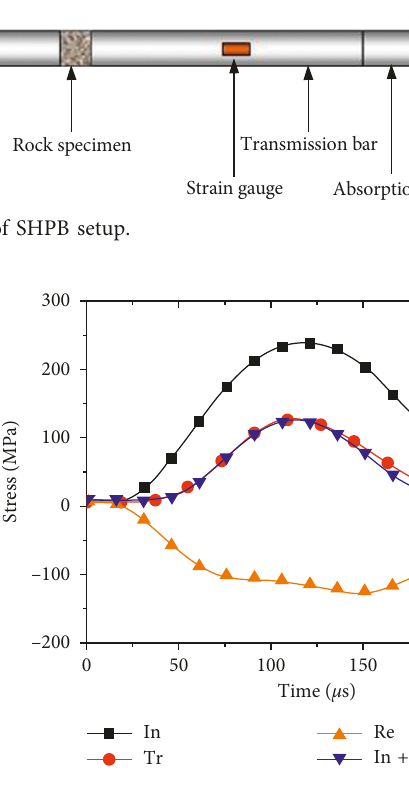
Figure 4: Dynamic force balance verified during a typical SHPB test.